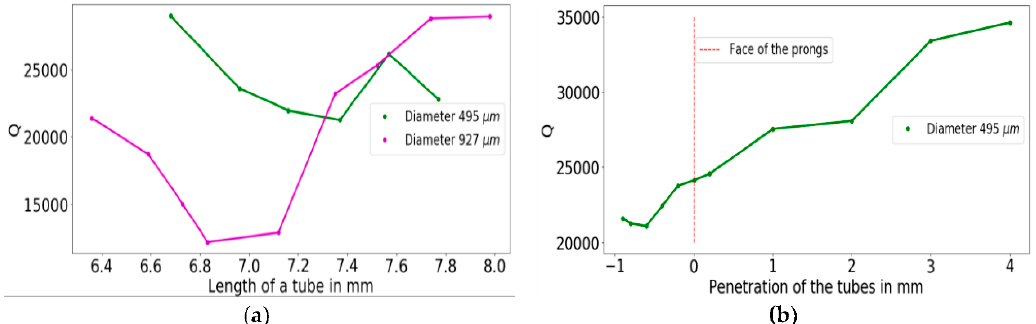
Figure 3. ( a ) Quality factor of the system {QTF + microresonators} as a function of the length of the tubes, for two di ff erent diameters of the tubes and a penetration depth of the tubes of − 0.8 mm with respect to the face of the prongs. ( b ) Same as ( a ) for tubes of same length and diameter, depending on the depth of penetration of the tubes within the gap between the prongs of the QTF. Q factor is measured with an